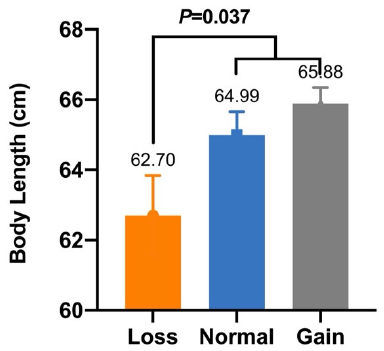
Figure 4. Association analysis between CNV3 and morphometric traits in SBWC goats: ( A ) cannon bone circumference and ( B ) chest depth.